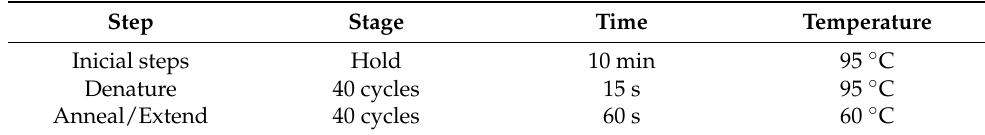
Table 4. Quality analysis: Results were analyzed with Taqman Genotyper software after determination in the Viia7 Real-time system (Thermofisher Scientific). Table 4. PCR Thermal cycler